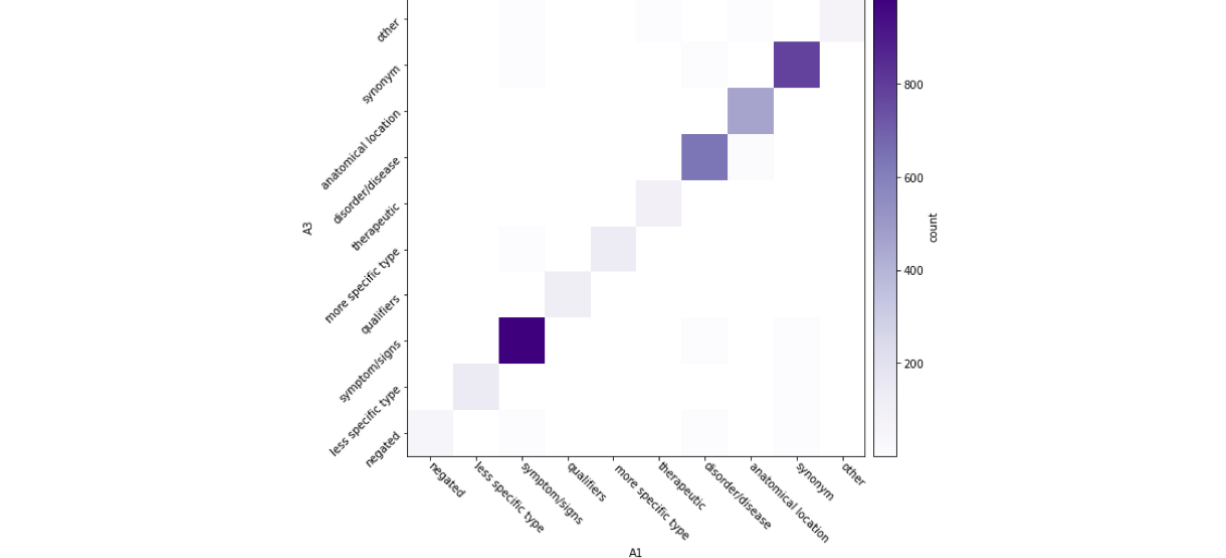
Figure 4. A1/A3 interannotator agreement of returned terms by semantic type.